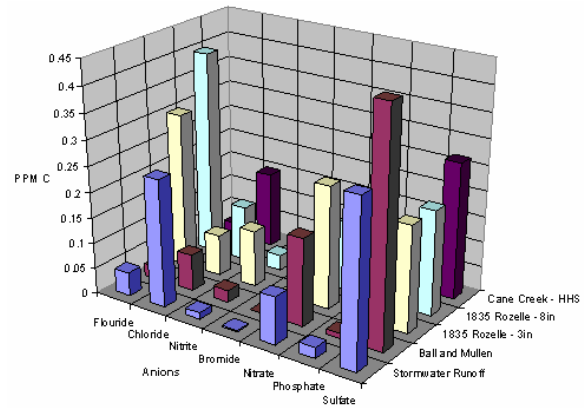
Figure 5: Ion Chromatography (IC) Results for Sampling Sites